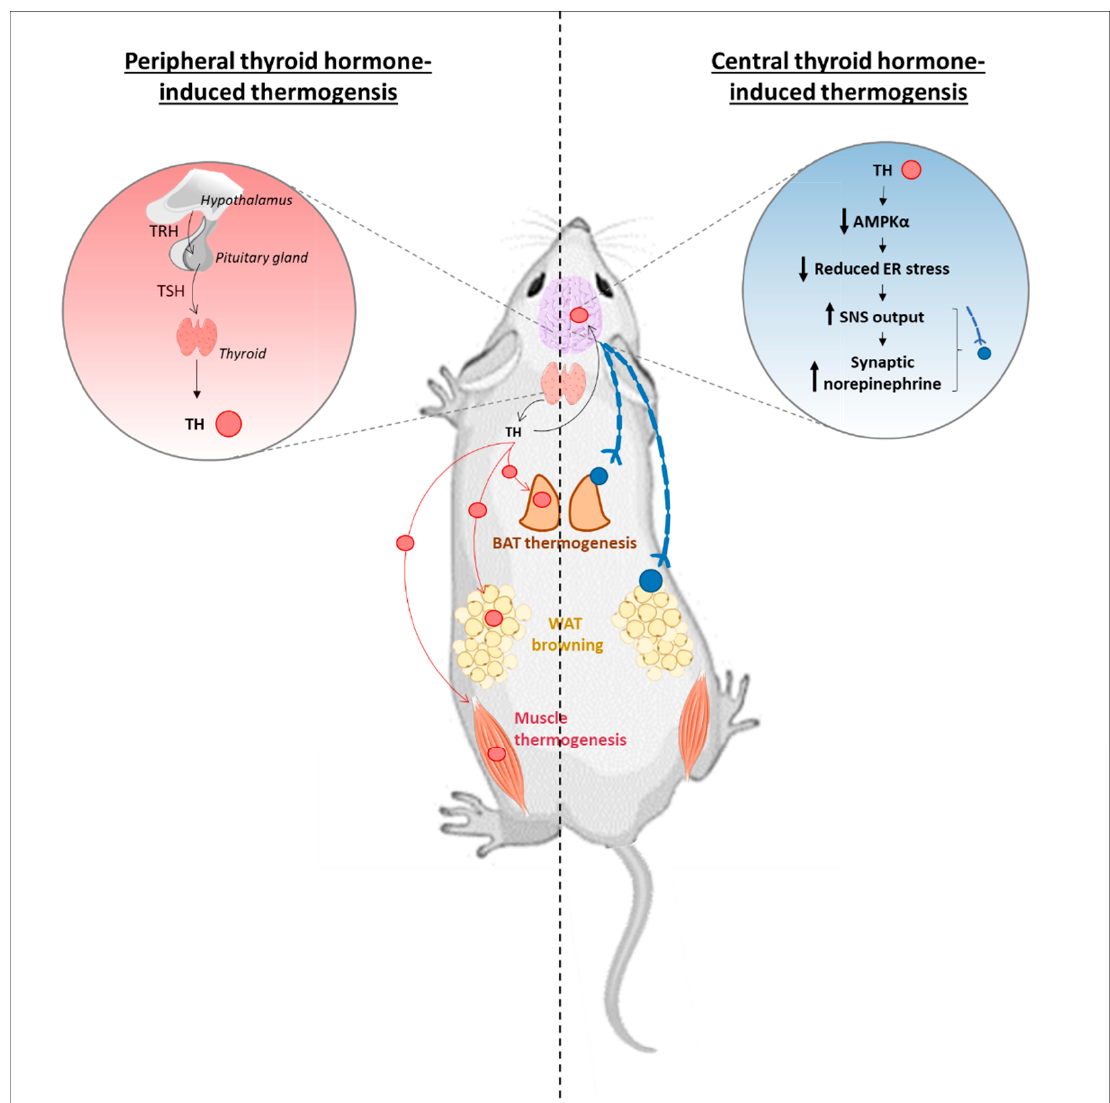
Figure 3. The different views for TH-induced adaptive thermogenesis . In the classical « peripheral » view ( left panel ), TH (red dots) are produced by the hypothalamic-pituitary-thyroid axis. TH are then released in the blood (red arrows) and are transported to targeted tissues. Then, they locally act on their receptors to trigger BAT and muscle thermogenesis, as well as WAT browning. This paradigm has been challenged by the description of a central mode of TH action to trigger adaptive thermogenesis ( right panel ). In this view, TH reaching the ventromedial medial hypothalamus decreases AMPK α phosphorylation in this region, alleviating endoplasmic reticulum (ER) stress. It leads to an increased sympathetic nervous system (SNS) output (axons drawn in blue) and the release of synaptic norepinephrine (blue dots) to trigger both BAT thermogenesis and WAT browning. However, no evidence as so far been brought to consider a TH-central control of muscle adaptive thermogenesis.